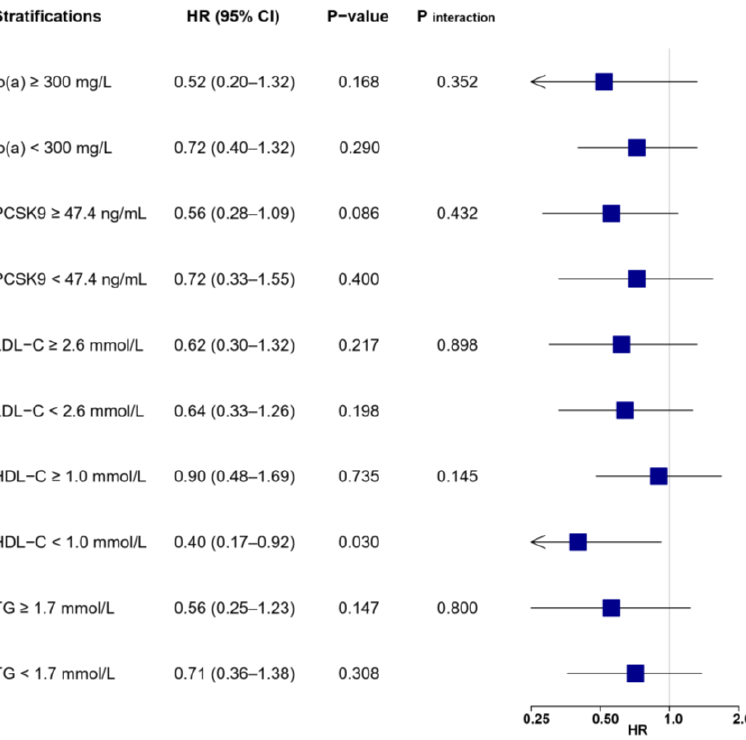
Figure 9. Associations between LL-37 and the risk of ischemic stroke according to lipid profile values. Multivariable Cox regression was adjusted for variables with p < 0.1 in univariable analysis (see Supplementary Table S6), including body mass index, hypertension, diabetes, previous myocardial infarction, systolic BP, diastolic BP, ejection fraction, glucose, hemoglobin A1c, N-terminal prohormone of brain natriuretic peptide, LDL-C, and successful revascularization. BP = blood pressure; HDL-C = high-density lipoprotein cholesterol; LDL-C = low-density lipoprotein cholesterol; lp(a) = lipoprotein(a); PCSK9 = proprotein convertase subtilisin/kexin type 9; TG = triglyceride.